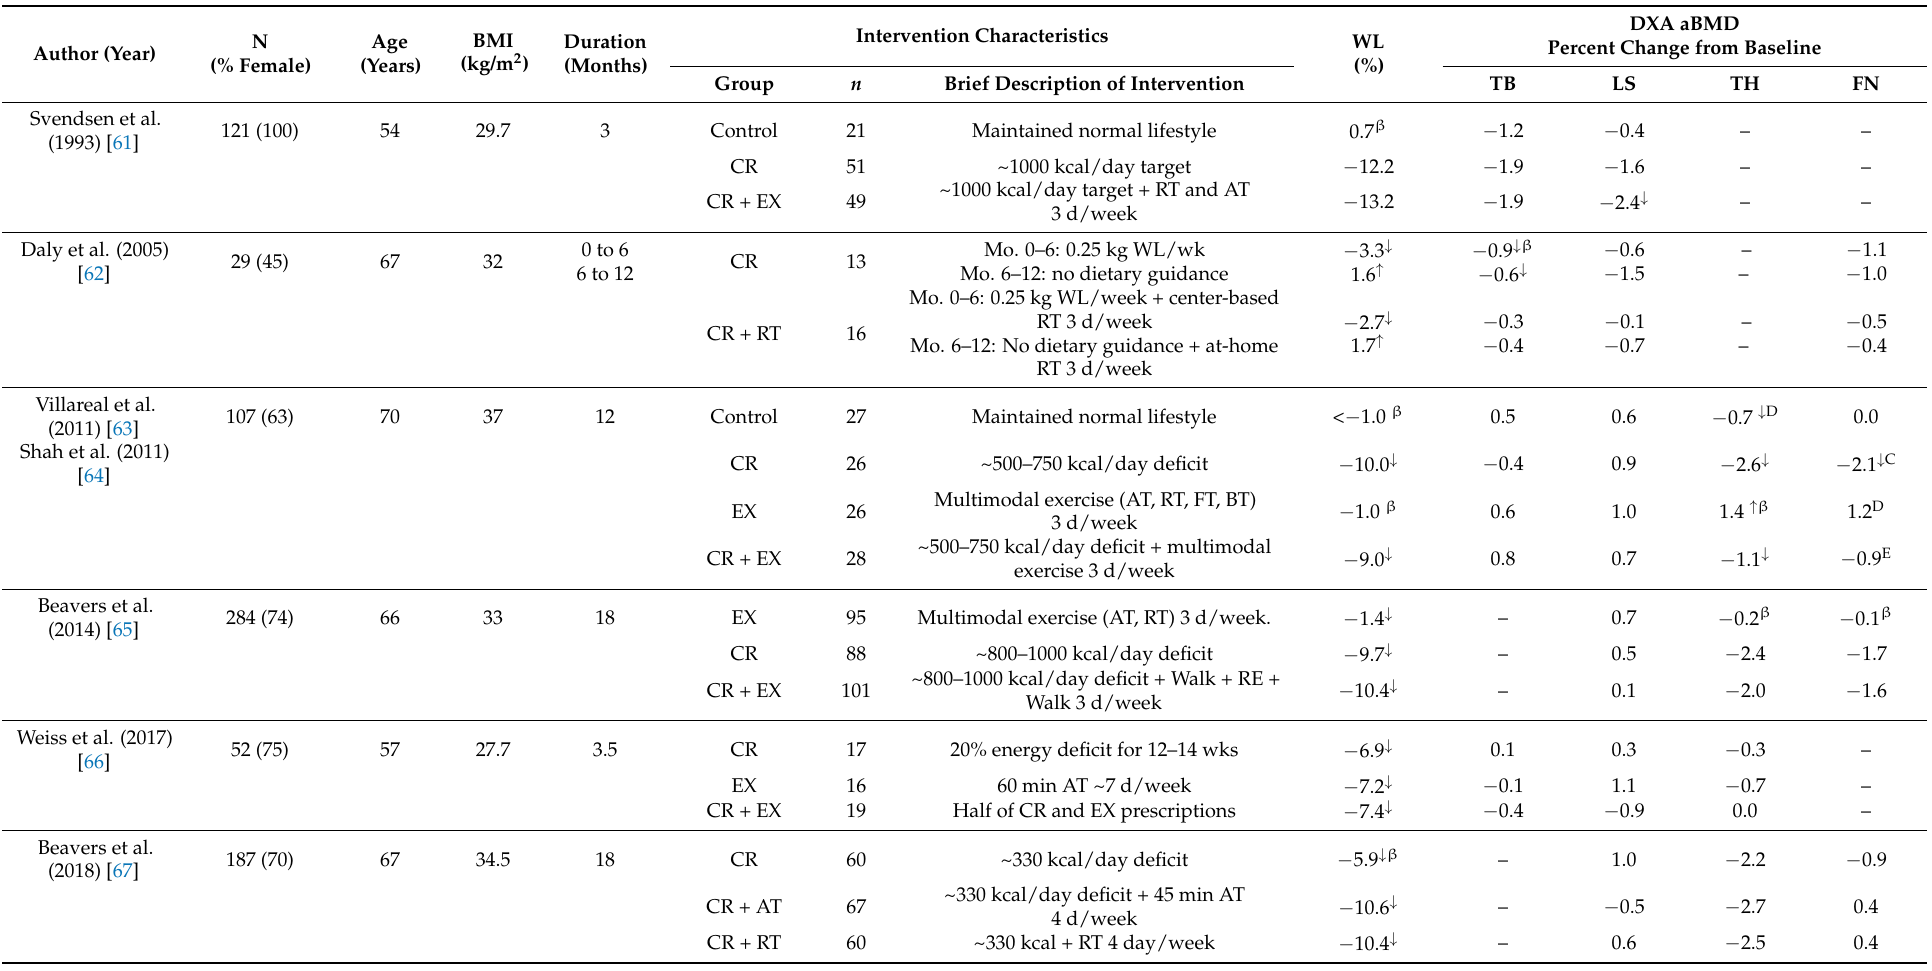
Table 2. Design characteristics of randomized controlled trials assessing the ability of exercise to mitigate caloric restriction-induced reductions in dual-energy x-ray absorptiometry- (DXA) acquired areal bone mineral density (aBMD) among older